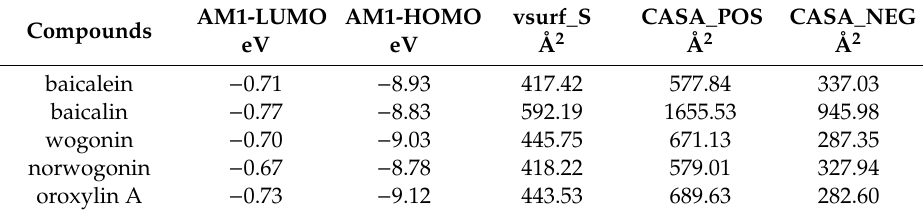
Table 5. Molecular features of natural compounds isolated from Scutellaria baicalensis